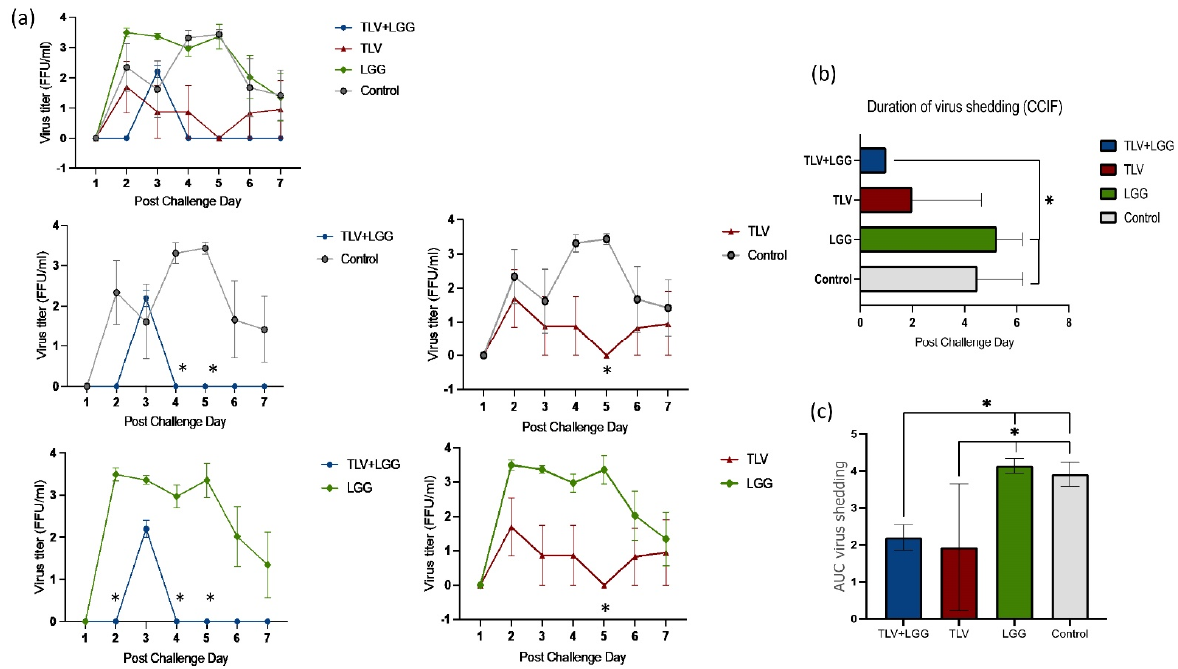
Figure 4 . Protection against virus shedding upon virulent Wa HRV challenge. Pigs were challenged orally with virulent Wa HRV at PID 28 and monitored 7 days postchallenge (PCDs 1 − 7) for duration and magnitude of virus shedding by CCIF. * Indicates significant difference when compared with the LGG or control group. ( a ) Mean virus shedding from PCDs 1 to 7 compared among all groups or compared pairwise between different groups. ( b ) Mean duration of virus shedding measured by cell culture immunofluorescence (CCIF). ( c ) Mean area under the curve (AUC) of virus shedding in each treatment group.